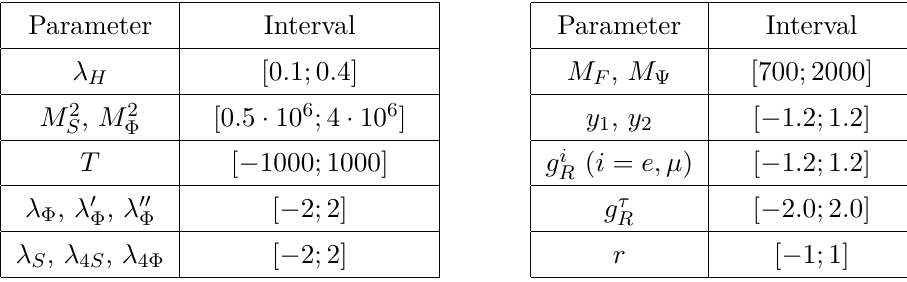
Table 2 . Independent input parameters of our Markov Chain Monte Carlo scan. All dimensionful quantities are given in GeV.